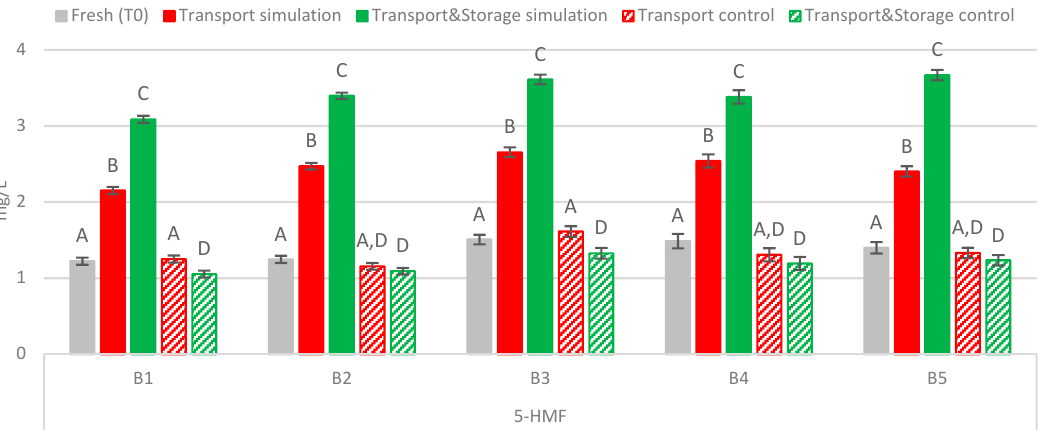
Figure 4. Evolution of 5-hydroxymethylfurfural under simulated conditions. A Tukey test was performed for each batch. Different letters represent statistically significant differences ( p < 0.05).